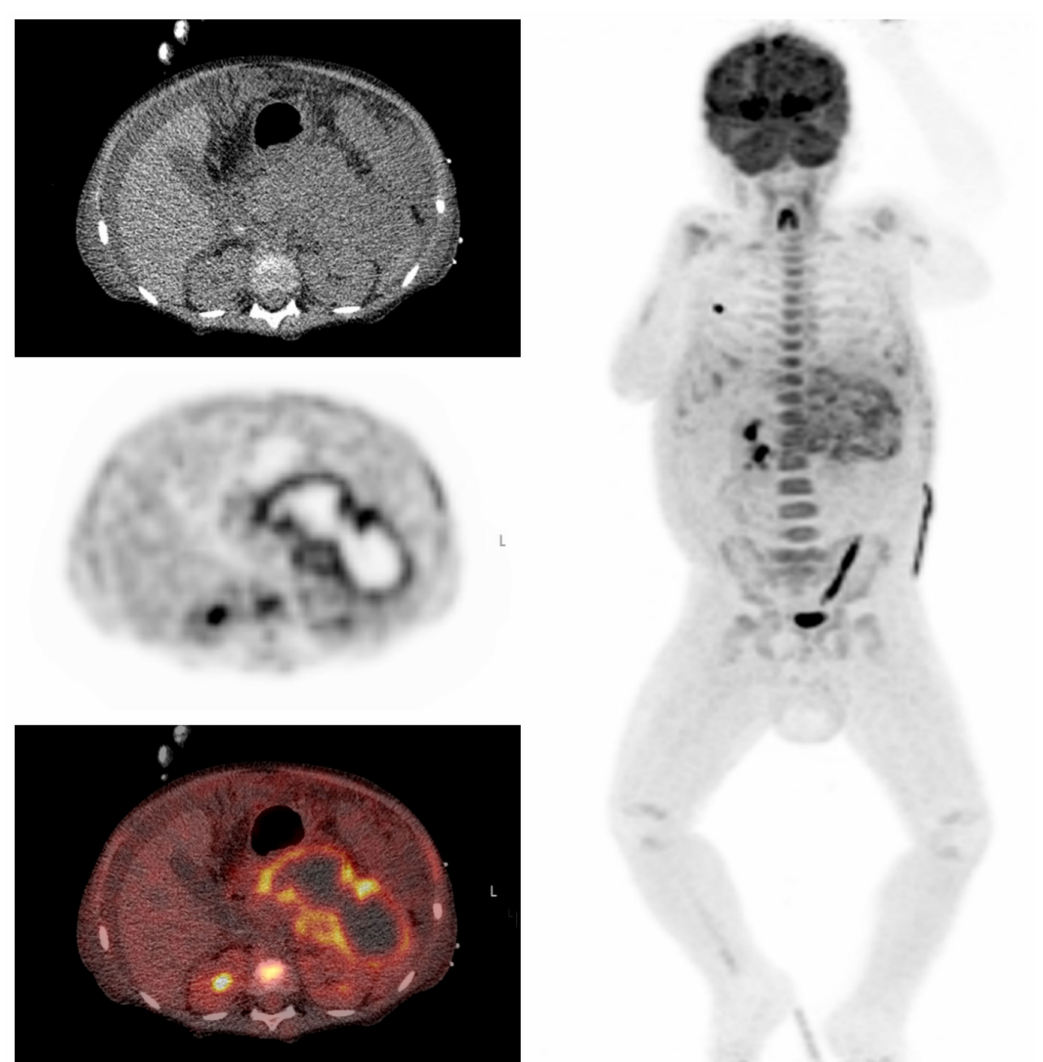
Figure 7. Clinical example 3. This scan shows an irregular hypodense lesion in the pancreatic region on low-dose CT and a photopenic area with hot rim on